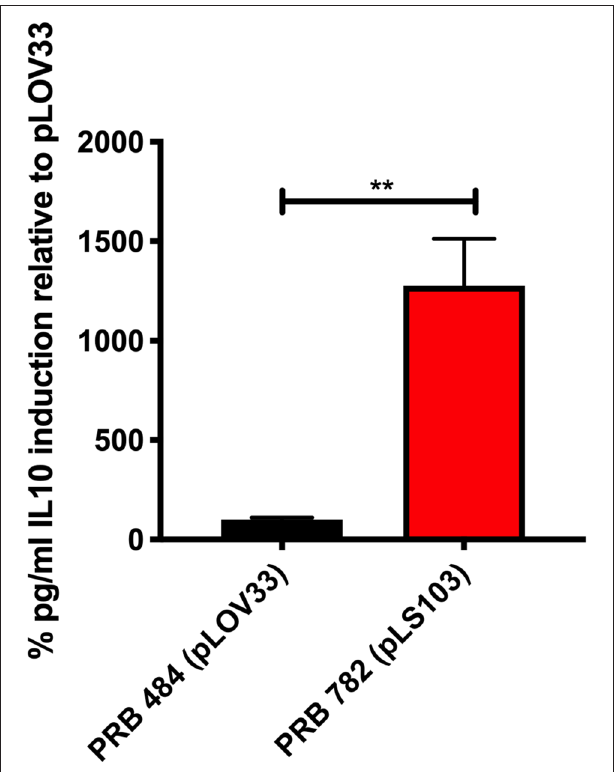
FIGURE 5 | PRB782 shows improved biological activity. Induction of IL-10 production with treatment of Colo205 cells with induced bacterial supernatant from PRB484 and PRB782 showed PRB782 to have significantly ( ∼ 15-fold) higher biological activity as compared to PRB484. Data represent the average of 3 biological replicates with error bars indicating standard deviation from the mean. Comparison performed with t -tests. ** P <